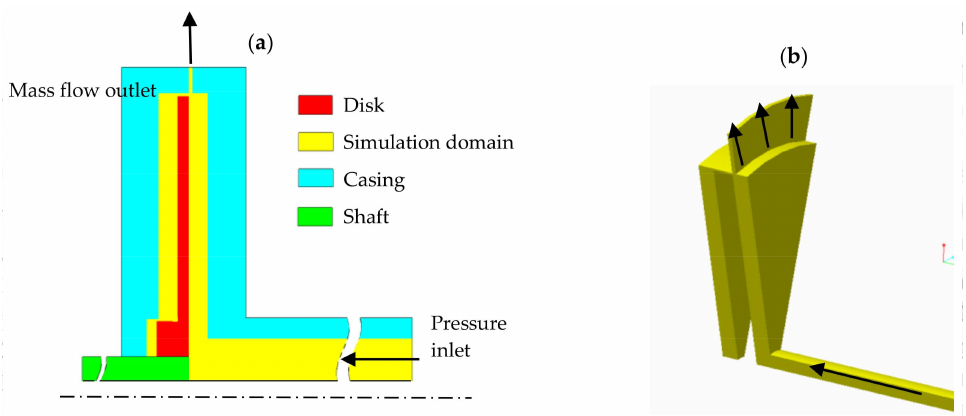
Figure 4. Domain for numerical simulation at G = 0.072: ( a ) Cross section of the cavity model and ( b ) Simulation domain.